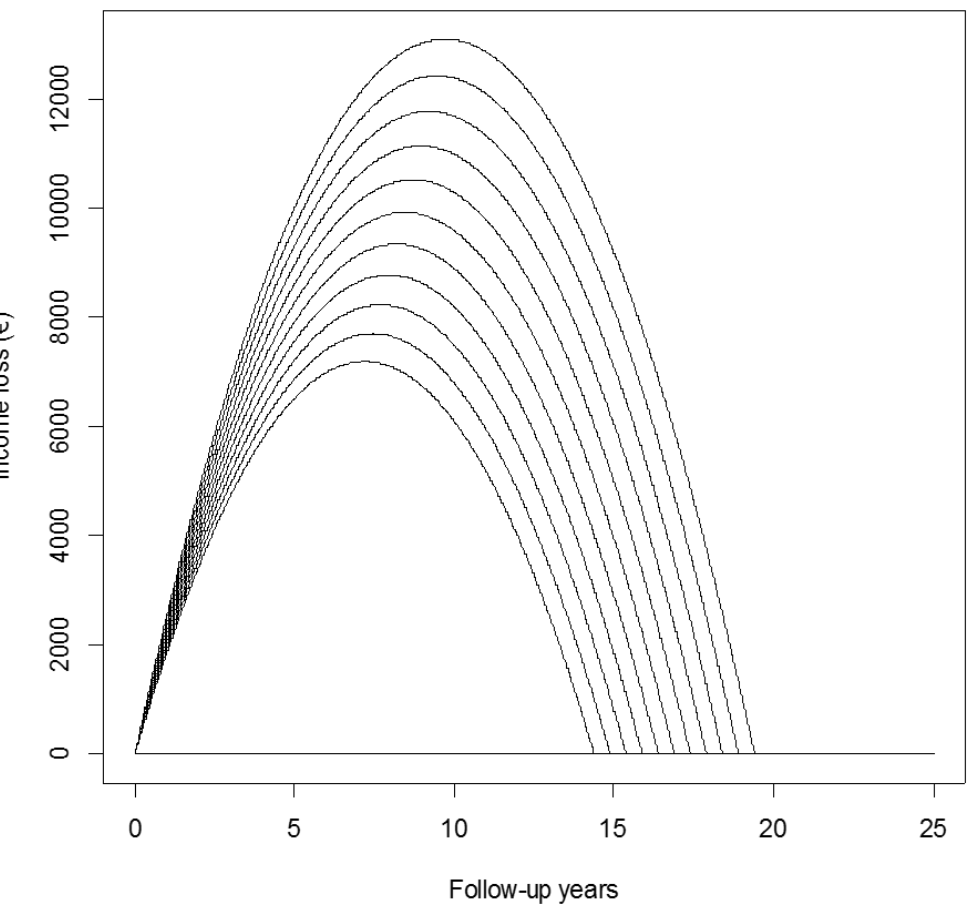
Figure 3: Income loss as a function of years since diagnosis for ages 45 (highest curve) to 55 (lowest curve) at